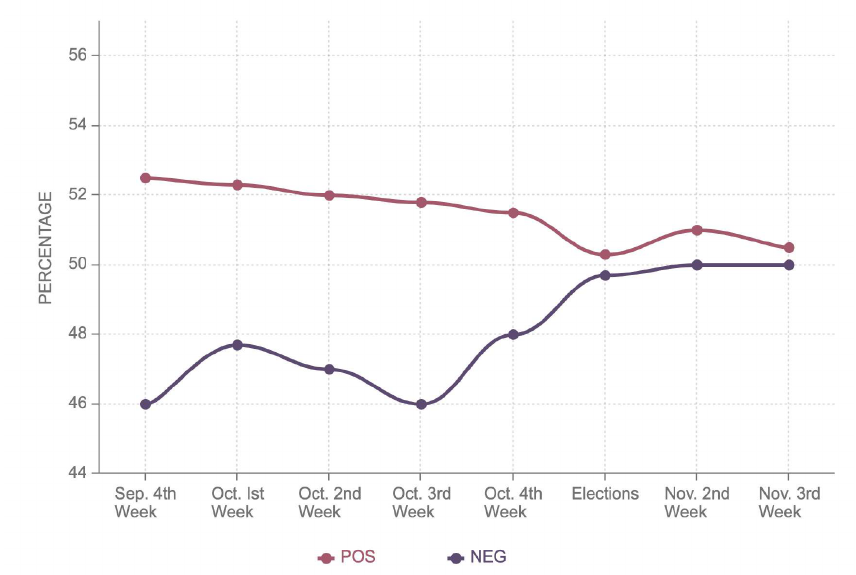
Figure 13. Graphs of positive and negative sentiments of Donald Trump in Wisconsin.